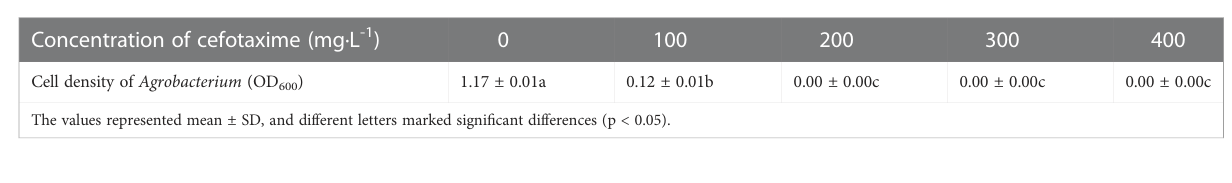
TABLE 4 Cefotaxime effects on Agrobacterium growth.